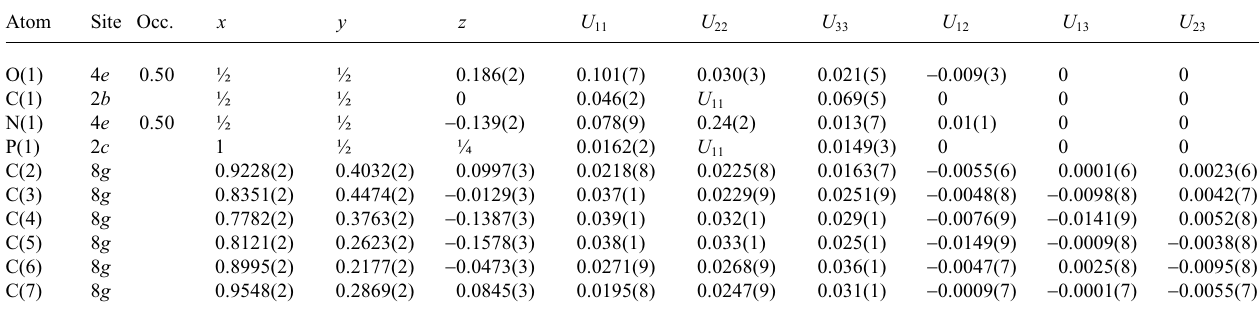
Table 3. Atomic coordinates and displacement parameters (in Å 2 ). Atom Site